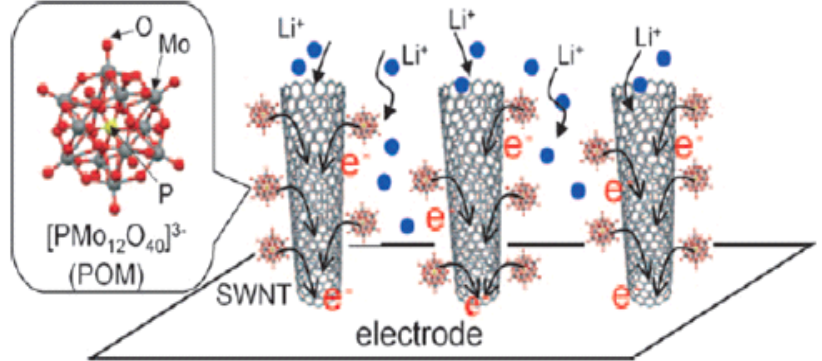
Fig. 8. Synthesis of cationic graphene nano-platforms supporting Ru 4 (SiW 10 ) 2 . Graphene is covalently functionalized with organic cations, which then bind Ru 4 (SiW 10 ) 2 through electrostatic interactions. Adapted from Ref [60].